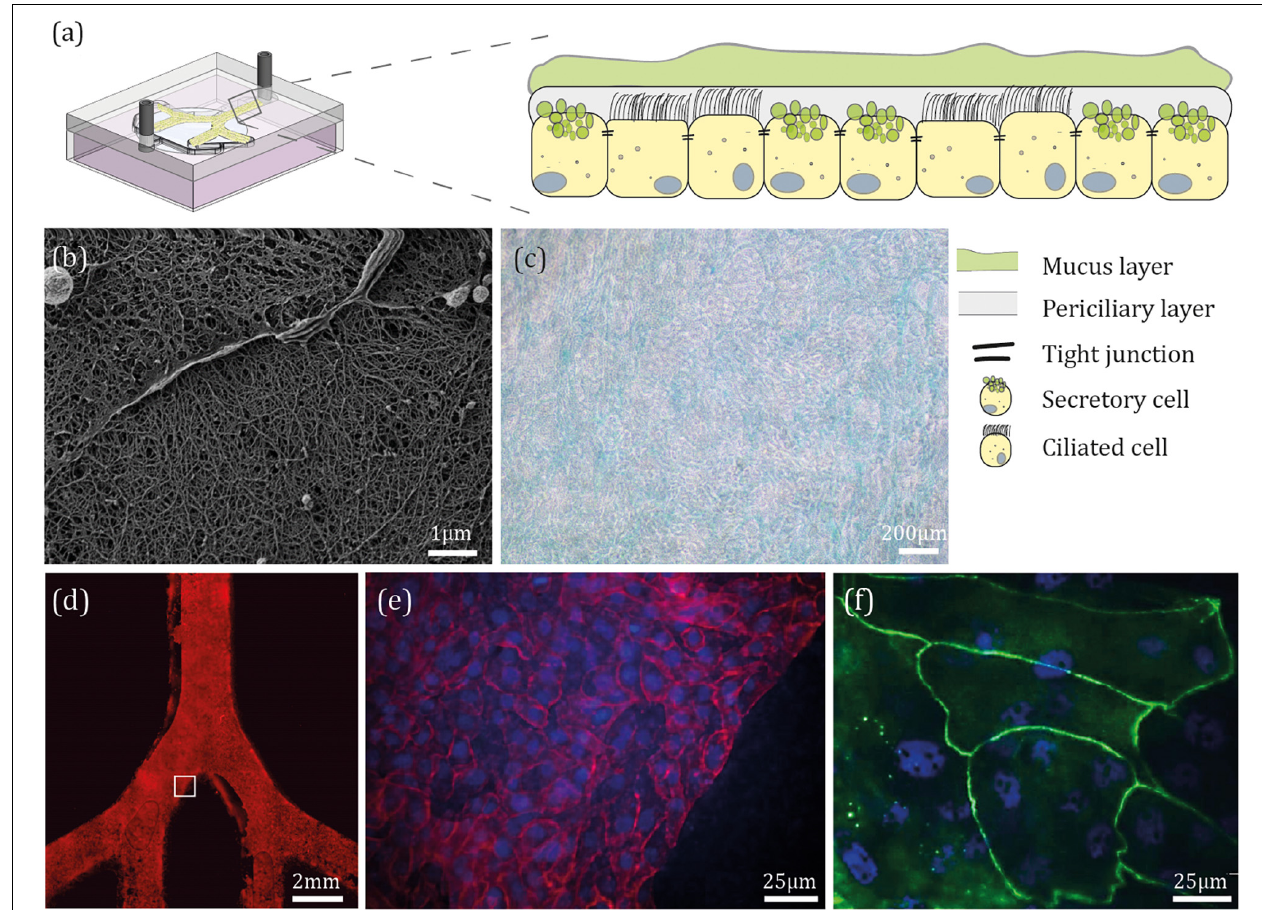
FIGURE 3 | Epithelial barrier reconstitution inside airway-on-chips . (a) Schematic illustration of the bronchial epithelium environment and the general differentiated cellular make-up. (b) Following device fabrication, NHBE cells were seeded on the apical side of the PET membrane under immersed conditions for 4 days, then cultured at ALI conditions for 21 days. Shown here is a scanning electron microscope (SEM) image of the mucus layer covering NHBE cells. (c) After 21 days at ALI conditions, NHBE cells were stained for glycoproteins typically present in mucus. (d) NHBE cells were cultured for 7 days under immersed conditions, then stained for F-actin. (e,f) After 21 days at ALI conditions, NHBE cells were stained for F-actin (red), ZO1 (green), and cell nuclei (blue).